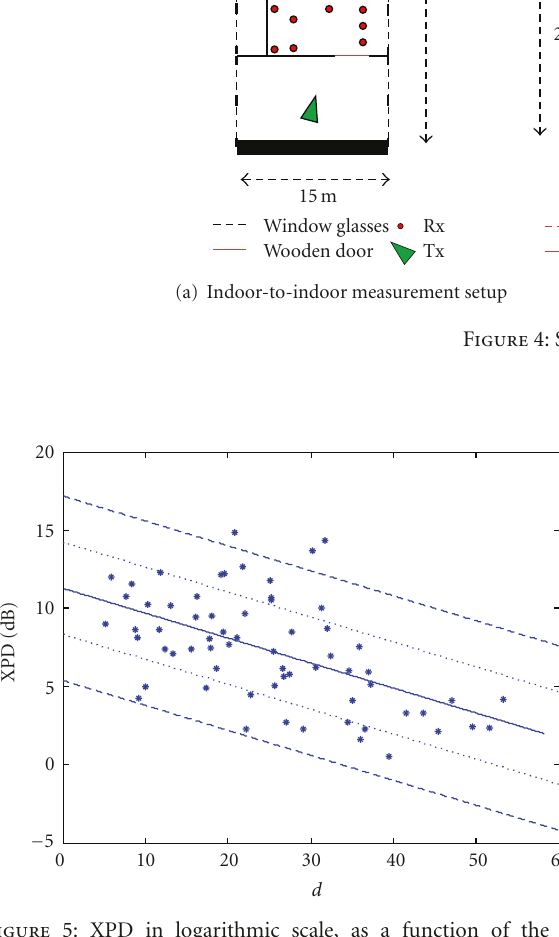
Figure 6: CDF of the XPD in the indoor-to-indoor scenario. This corresponds to d/d 0 ≈ 1 . 67 and it can be seen from Figure 3(a) that this value is in the accessible region. The propagation model G 3 ( d , d ref ) is used and the other relevant parameters are θ = 10 dB, XPD 0 = 4–10 dB, and α =